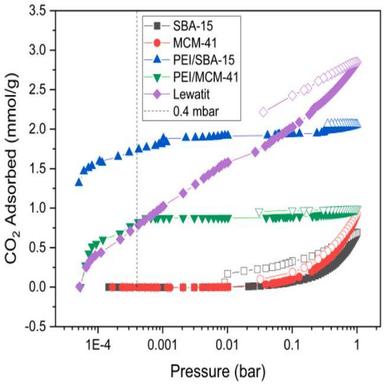
a) Representative excess pure CO2 sorption isotherms at 25 ◦C (298 K) as a function of absolute CO2 pressure for SBA-15, MCM-41, PEI/SBA-15, PEI/ MCM-41, and Lewatit. The dotted line marks CO2 uptake at 0.4 mbar (equivalent partial pressure to 400 ppm). Filled symbols are for adsorption; open symbols are for desorption. Uptake is given as mmol of CO2 per g of dry sample.